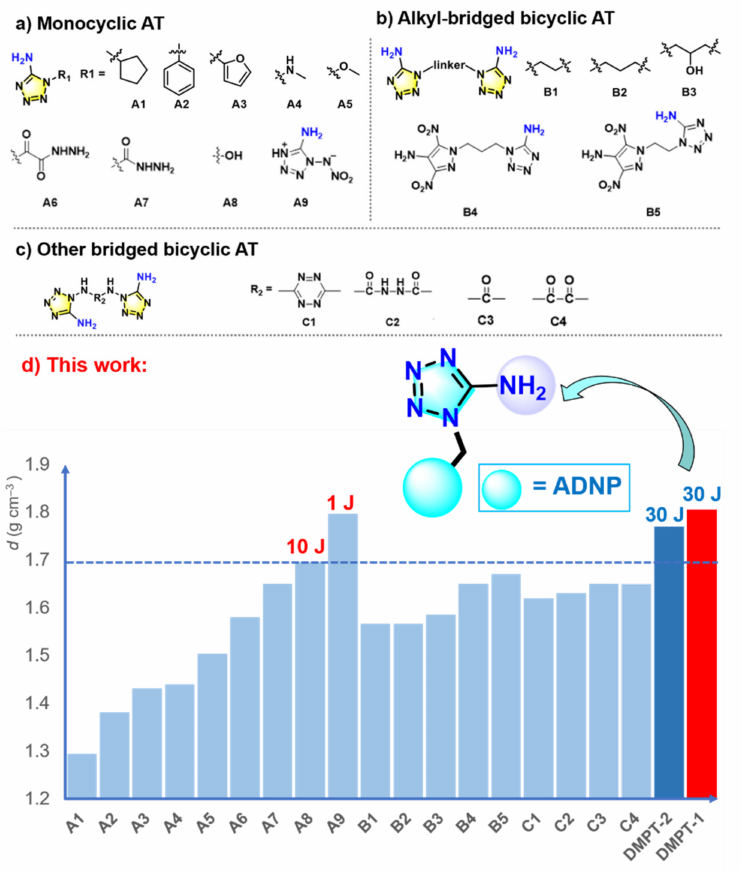
Scheme 2. ( a ) Monocyclic derivatives of 5-aminotetrazoles ( A9 : determined by X-ray diffraction and converted into room-temperature values); ( b ) alkyl-bridged bicyclic 5-aminotetrazoles; ( c ) other bridged bicyclic 5-aminotetrazoles; ( d ) bar graph of density and impact sensitivity for AT -based energetic